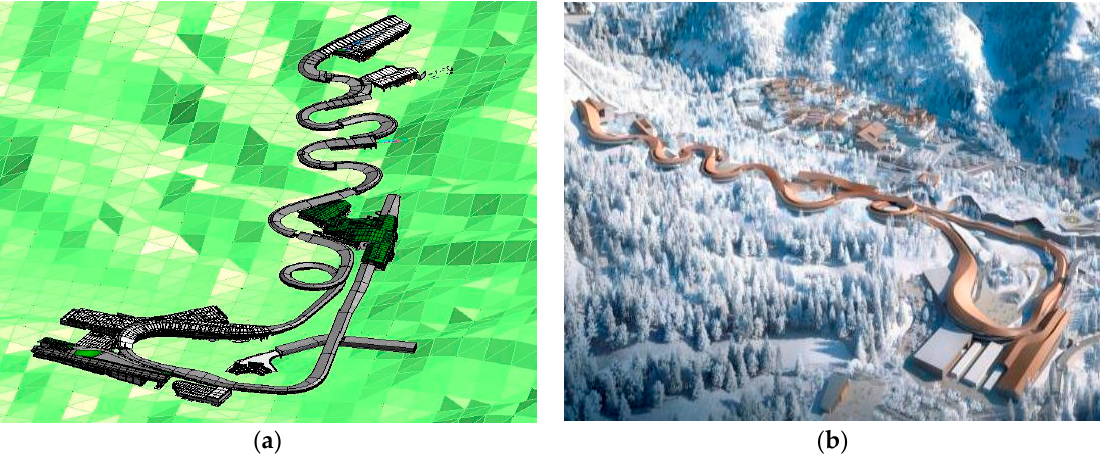
Figure 9. Effect map of sports venues. ( a ) Combination of BIM and GIS; ( b ) twin model of venues.